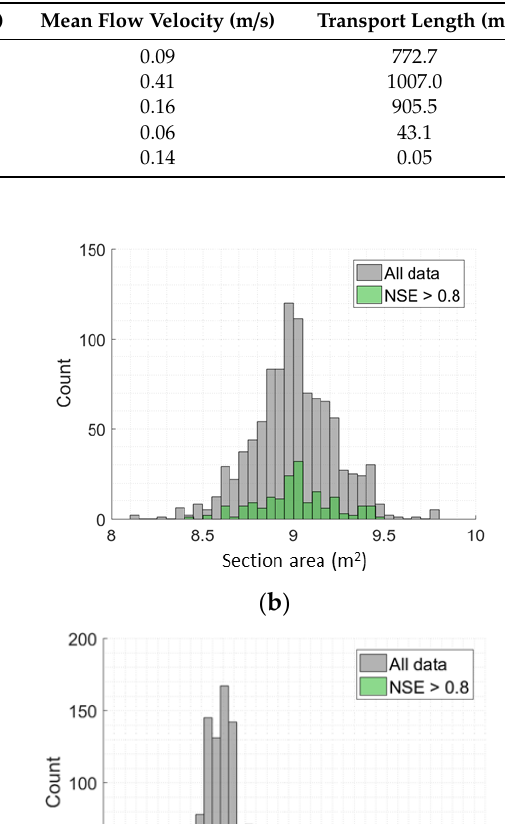
Table 1. Statistics based the simulation with an NSE > 0.8 (174 simulations).